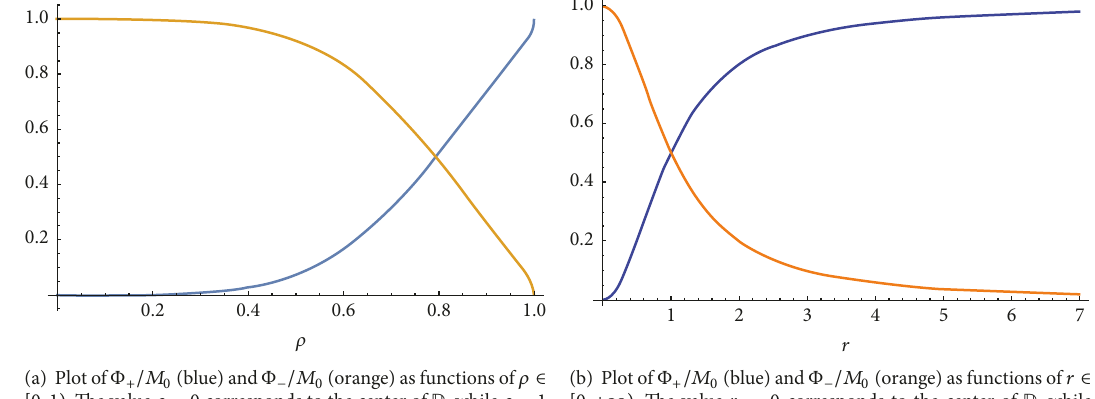
(a) Plot of Φ + /𝑀 0 (blue) and Φ − /𝑀 0 (orange) as functions of 𝜌 ∈ (b) Plot of Φ + /𝑀 0 (blue) and Φ − /𝑀 0 (orange) as functions of 𝑟 ∈ [0,1) . The value 𝜌 = 0 corresponds to the center of D , while 𝜌 = 1 [0,+∞) . The value 𝑟 = 0 corresponds to the center of D , while 𝑟 = +∞ corresponds to the plane end. Only the potential Φ + leads corresponds to the conformal boundary 𝜕 ∞ D . Only the potential Φ + leads to 𝛼 -attractor behavior when inflation takes place near to 𝛼 -attractor behavior when inflation takes place near the plane the plane end end Figure 2: The potentials Φ ± on the Poincar´e disk.